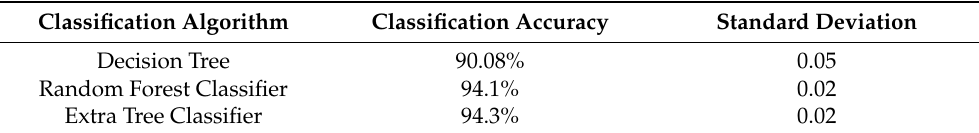
Table 2. Statistical metrics of classifier